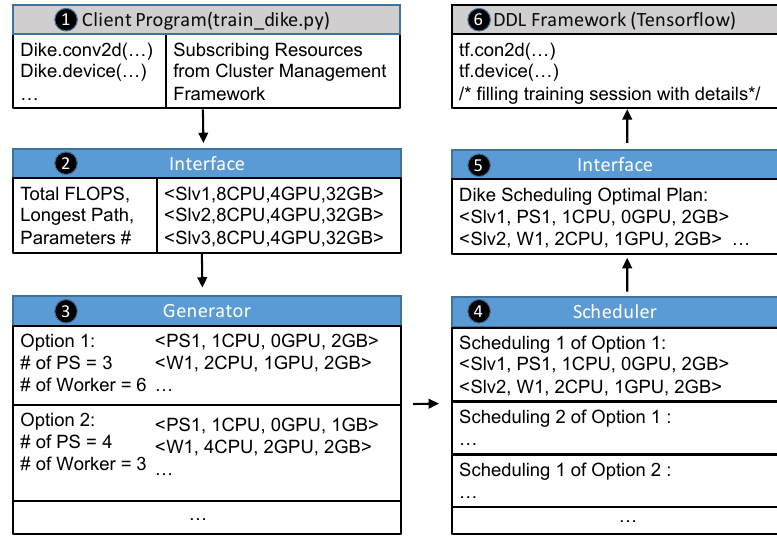
Figure 3. Detailed process of